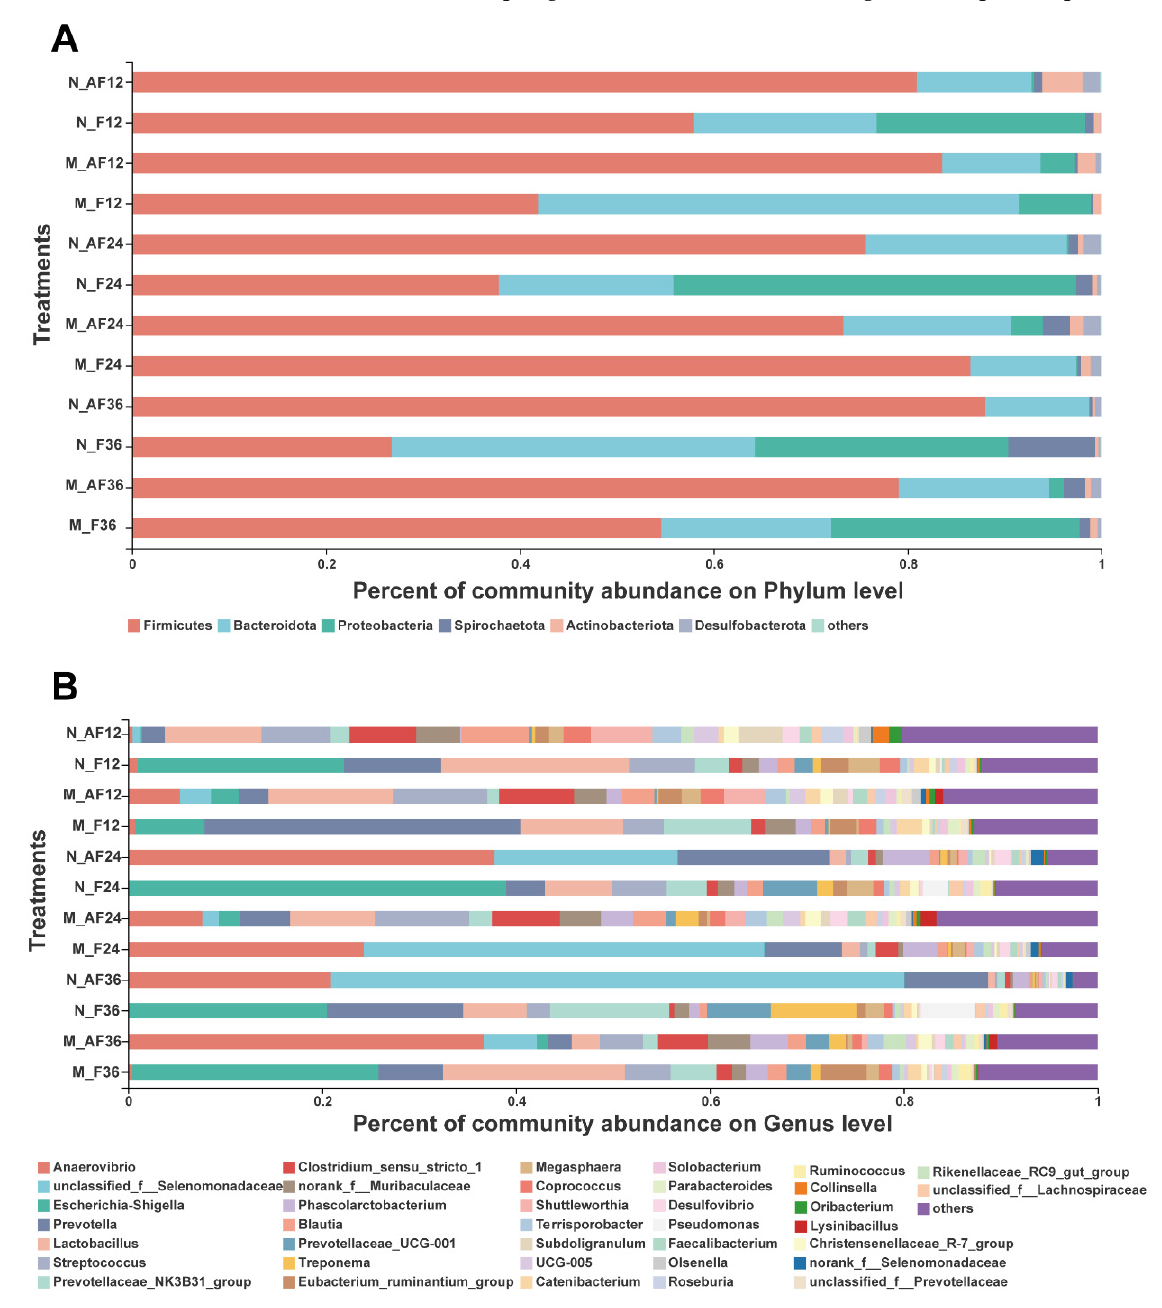
Figure 6. The microbial composition at the phylum ( A ) and genus ( B ) level with an abundance greater than 1% in fermentation broth at 12, 24 and 36 h. ( n = 3; N_AF, normal medium with anti-frozen inoculum; N_F, normal medium with frozen inoculum; M_AF, modified medium with anti-frozen inoculum; M_F, modified medium with frozen inoculum).